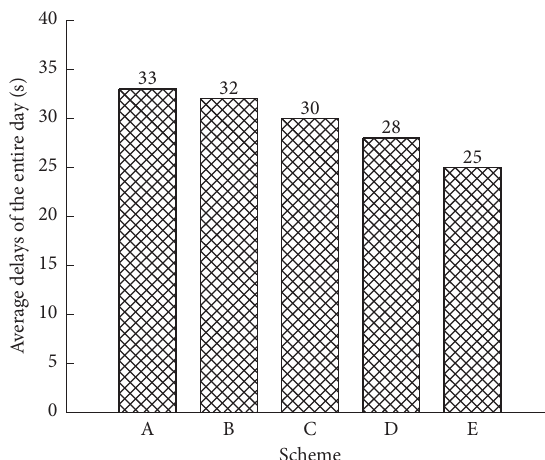
Figure 13: Comparison of the average vehicle delay at the Jiuhua road and Zheshan road intersection throughout the